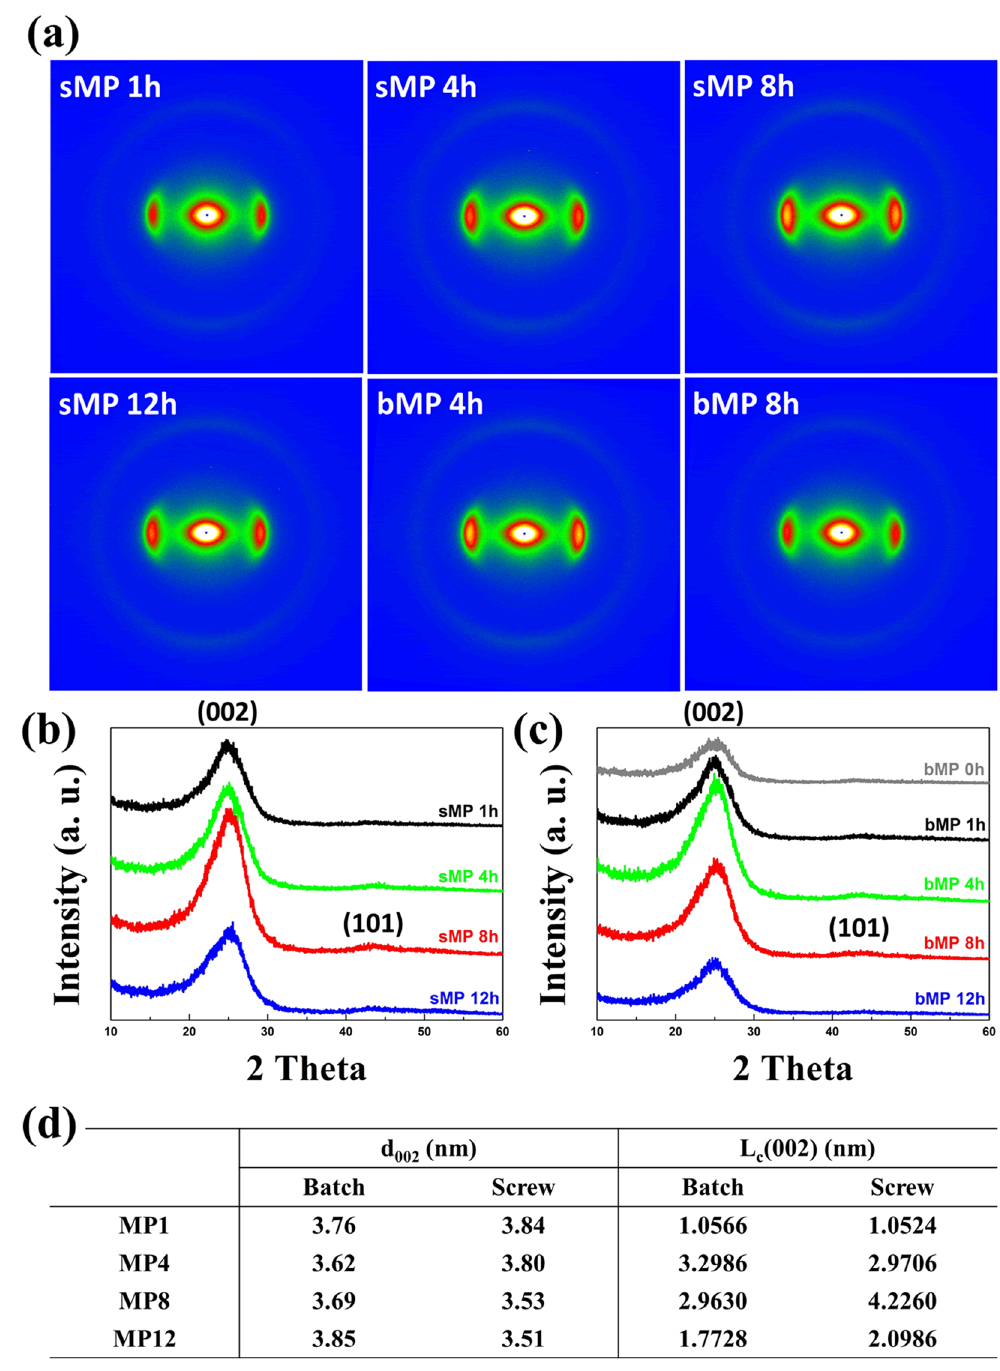
Figure 4. ( a ) 2D SAXS patterns of MP CFs. ( b ) and ( c ) show the XRD profiles of sMP and bMP CFs according to their oxidation time. Table ( d ) displays the XRD parameters for the MP